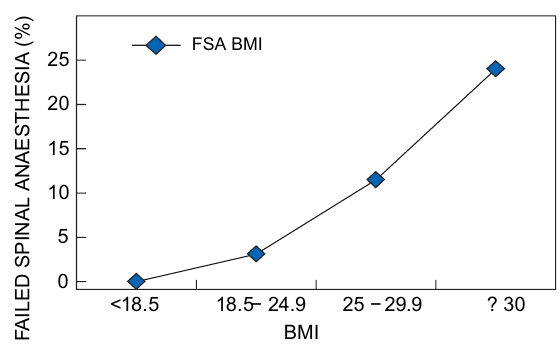
Figure 1: Body mass index and outcomes of spinal